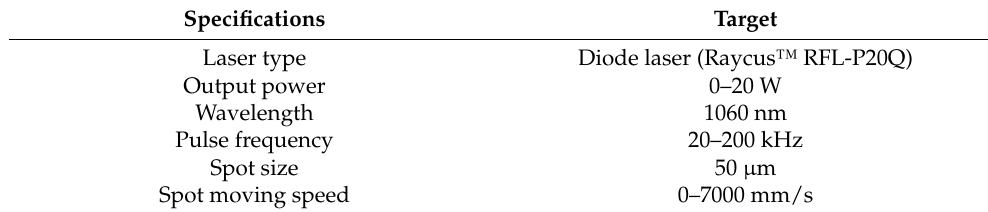
Table 1. Specifications of the laser marking system.